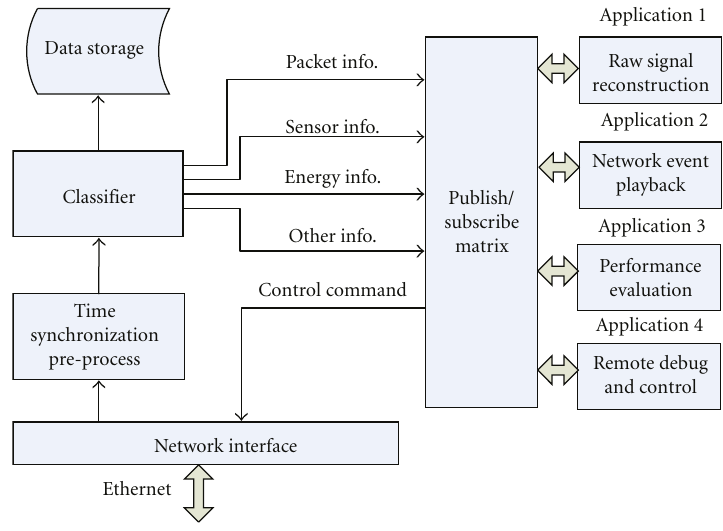
Figure 9: Block diagram of HINT test server.